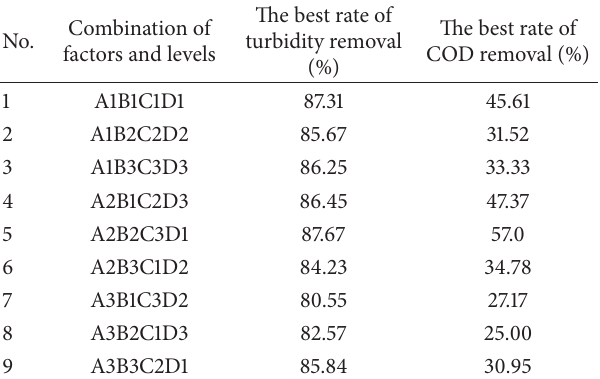
Table 3: Results of jar test for sewage.